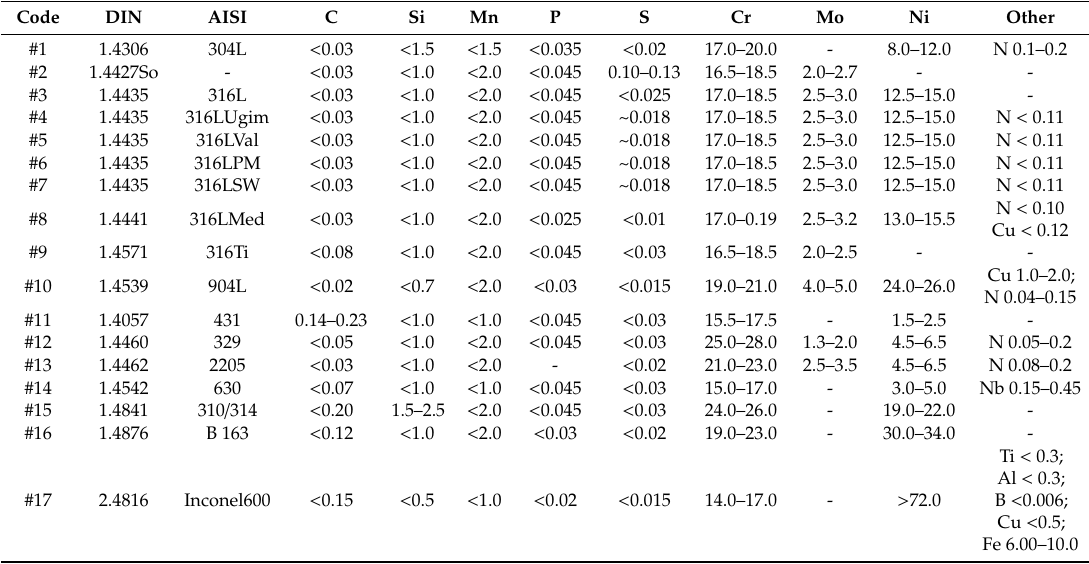
Table 1. Chemical composition (wt.%) of the grades of austenitic steels used in corrosion tests.